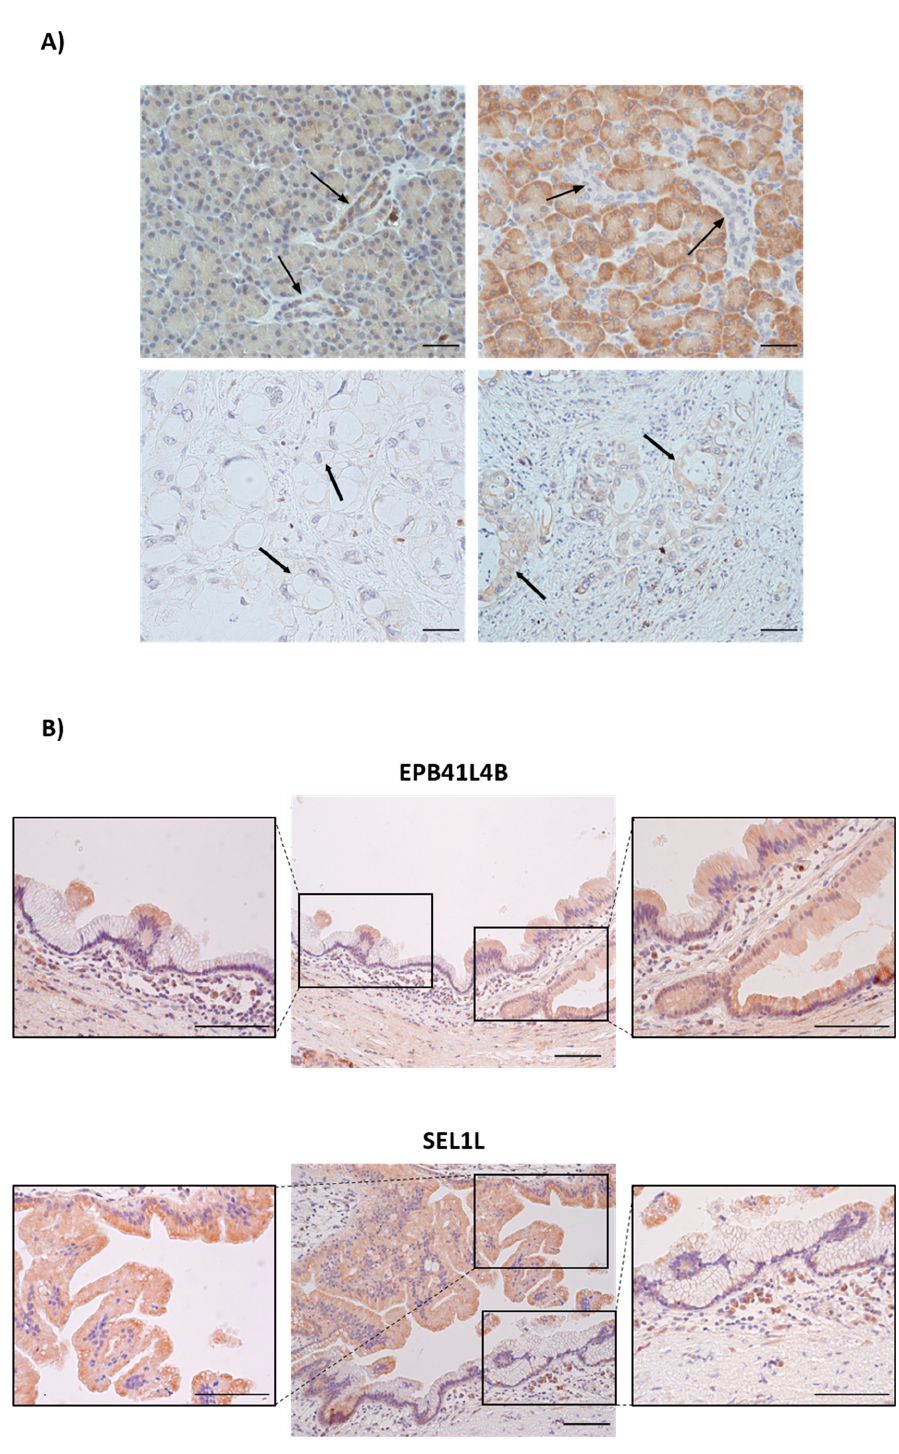
Figure 8. Immunohistochemistry staining of EPB41L4B and SEL1L in Healthy, IPMN and PDAC tissues. ( A ) EPB41L4B and SEL1L staining in healthy pancreatic tissue and PDAC. Arrows highlight ductal structures. Magnification: 40 × . Scalebars size 50 µ m. ( B ) Panel showing staining of EPB41L4B and SEL1L in IPMN. The central panel images were taken at 20 × magnification. Representative images from Healthy ( n = 4), IPMN ( n = 3) and PDAC ( n = 4) pancreatic tissues. Lateral detail images were taken at 40 × magnification. Scale bars size 100 µ m in all of the images of the